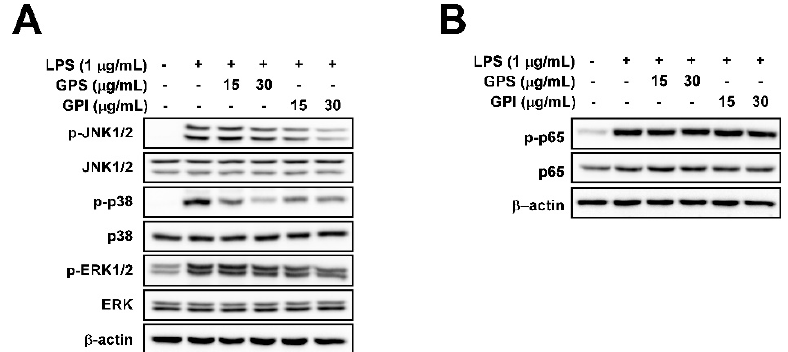
Figure 2. E ff ects of GPEs on LPS-induced nitrite production, cell viability, and phosphorylation of MAPKs and p65 in RAW 264.7 cells. ( A ) GPE suppressed the LPS-induced nitrite production in RAW 264.7 cells. Cells were pretreated with GPE in the presence or absence of LPS (1 µ g / mL) for 24 h. ( B ) GPEs did not a ff ect the cell viability at the tested concentrations. The cells were treated with increasing concentration of GPE for 24 h. ( C ) GPEs suppressed the LPS-induced iNOS and COX-2 expression in RAW 264.7 cells. ( D ) Quantification of iNOS suppression by GPEs. Expression levels of iNOS, COX-2, and β -actin were determined by western blot. Data are presented as mean ± SD of three independent experiments. # p < 0.05 between control and LPS-exposed cells (no GPE); * p < 0.05; ** p < 0.01.